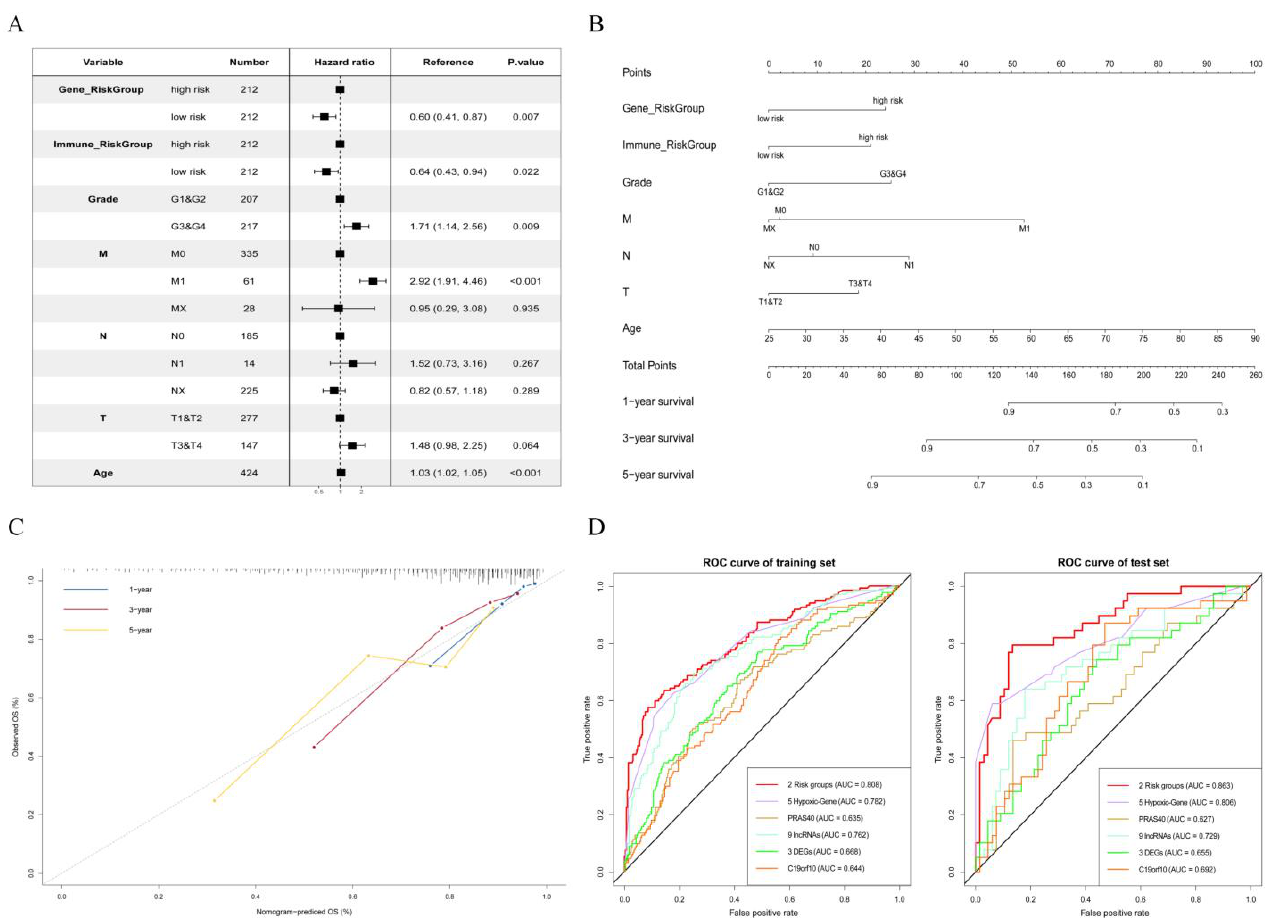
Figure 5. Nomogram for predicting overall survival (OS) in KIRC. ( A ) Multivariate Cox regression